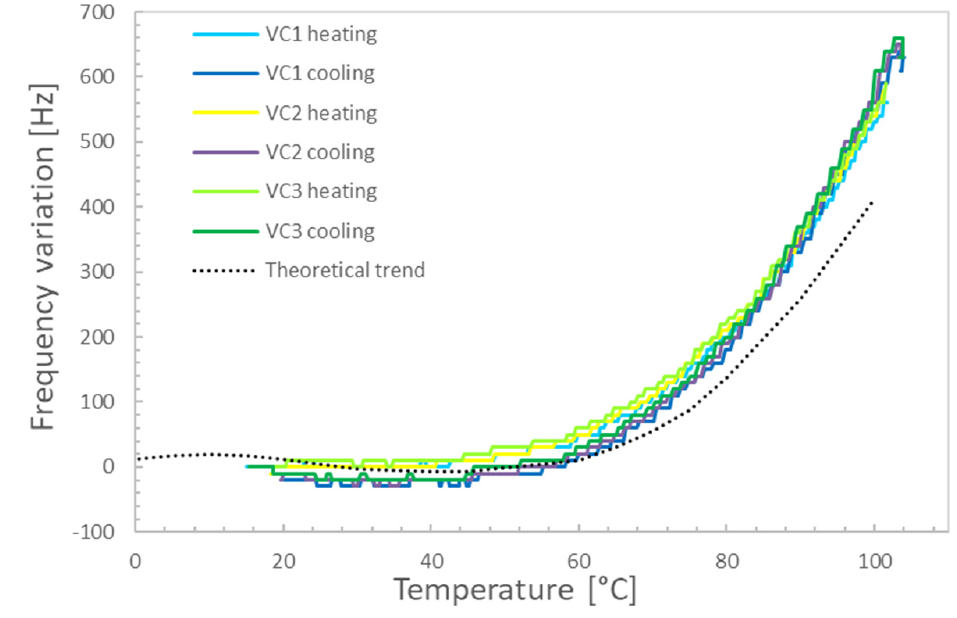
Figure 4. QCM calibration in a uniform temperature environment: results of three subsequent cycles. Comparing the measured trends, it was found that the measurement repeatability (1 σ band) was about 12.6 Hz. In fact, despite the curve is similar for the various cycles and not far from the theoretical one [7] for AT-cut crystals, analyzing the measured trends in detail, it can be shown that the measured frequency variation is characterized by a negative drift of the frequency curves with time, evidencing that some condensation was occurring. This problem is related to the chamber cleanliness and the achieved vacuum level, which, being in the range of a few Pa, does not warrant the removal of the outgassed components that at least partially also condense on the crystal. Nevertheless, the obtained result was judged to be accurate enough for the intended application, and it was decided to keep the contamination effect as part of the procedure uncertainty. Thus, a third-order polynomial was extracted from the measured data to model the frequency change vs. temperature in uniform temperature conditions. The best fitting result considering all three cycles is given in Table 1. Table 1. Third-order polynomial coefficients from the best calibration data